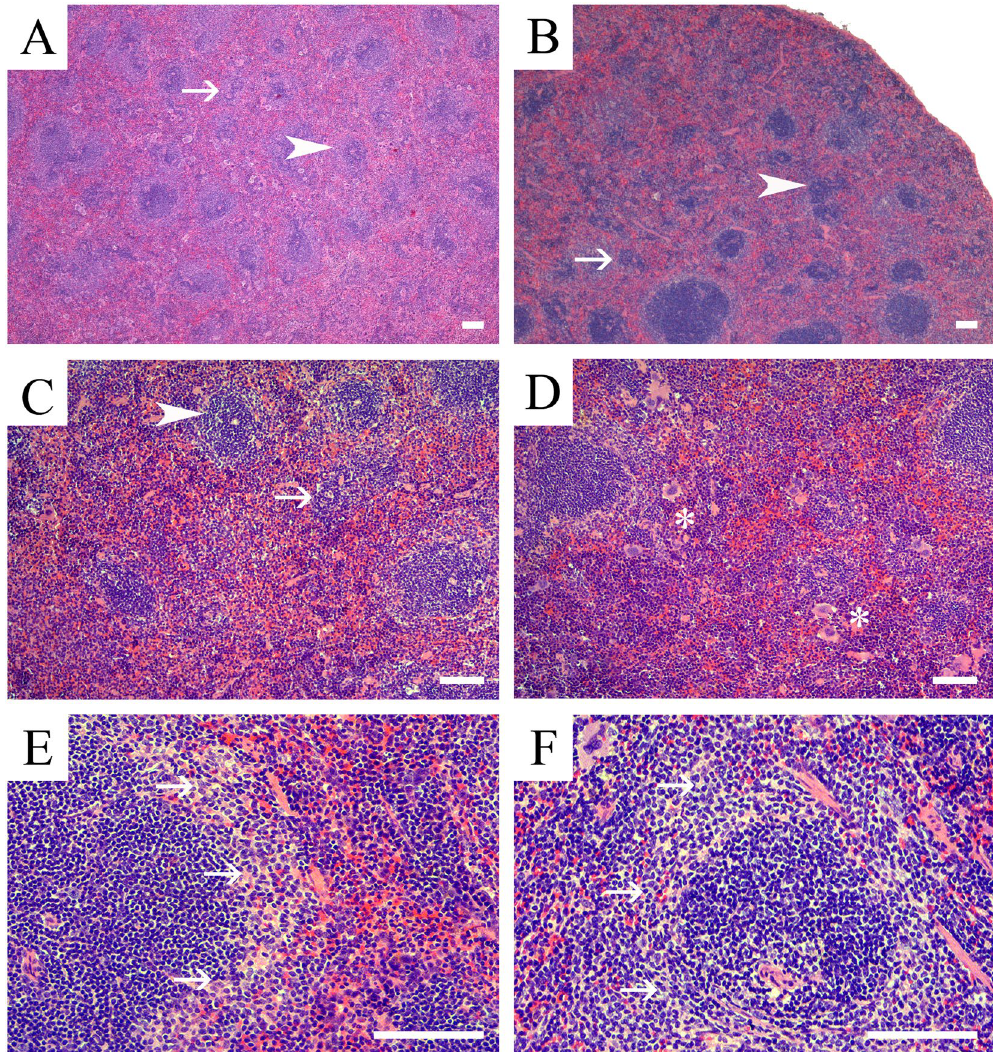
Figure 3. Representative photomicrographs of splenic microanatomical structures in EE and BPA-exposed adult male and female CD-1 mice. Shown are representative H&E stained sections of splenic tissue from ( A ) a male mouse exposed to BPA (0.03 ppm), and ( B ) a female mouse exposed to 3 ppm BPA. These are illustrative of the representative phenotypes in males and females that was characterized by decreased PALS (arrowhead) numbers, size, and lymphocyte cellularity (arrow). These effects were typically more pronounced and diffuse in male versus females. ( C ) High magnification image of a male spleen representative of the 0.03 ppm BPA exposure group and demonstrating decreased PALS (arrowhead) size, numbers and lymphocyte cellularity (arrow), along with decreased primary lymphoid follicles cellularity (arrow). ( D ) High magnification image of a representative female spleen from the 3 ppm BPA exposure group characterized by decreased PALS numbers and cellularity with decreased lymphoid follicle cellularity. In addition to the white pulp changes, BPA-exposed females also had increased hematopoietic precursor populations (EMH) within the red pulp, which were predominantly of erythroid lineage (asterisks). Shown is a representative image of a section from a 0.0001 ppm EE-exposed male ( E ) and female from the 0.03 BPA group ( F ) showing prominence of marginal zones, a phenotype that was observed in primarily males from EE exposure groups and female from both BPA- and EE- groups. Scale bars indicate 100 µ